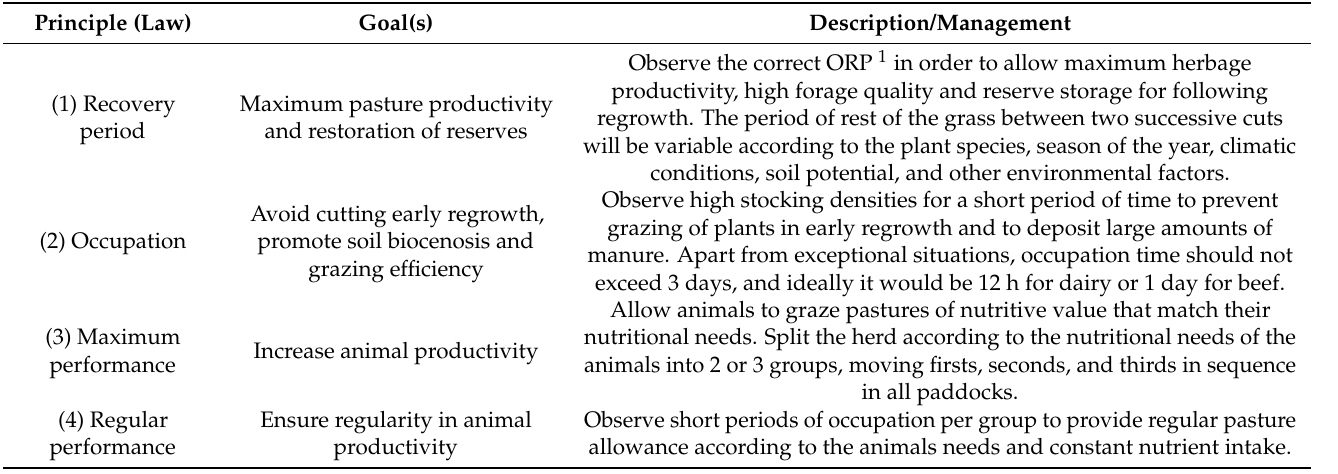
Table 1. The four “laws” (principles) of Voisin Rational